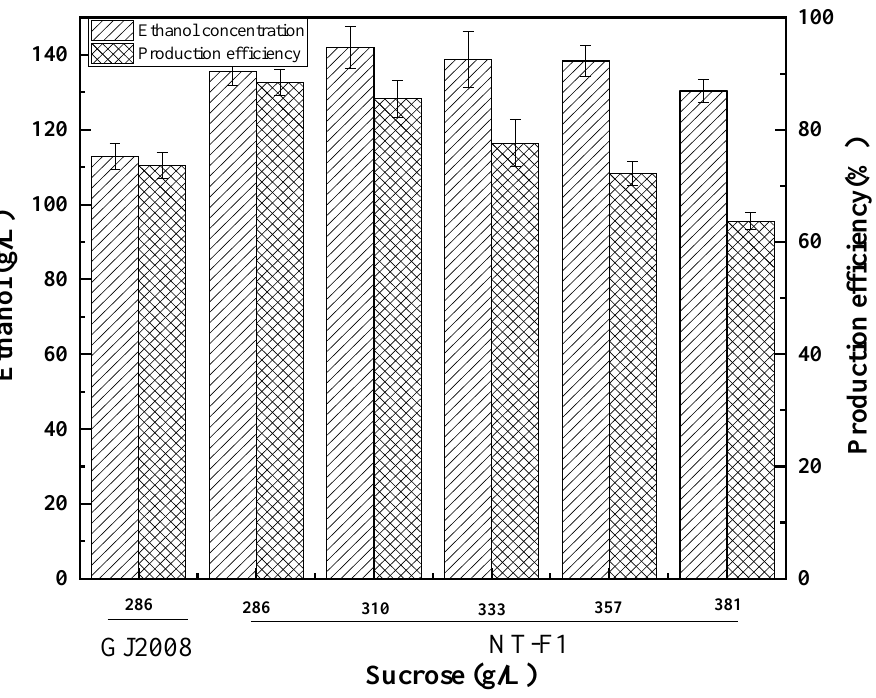
Figure 6. Optimization of sucrose ethanol synthesis by mutant strain. Sucrose fermentation media of 286, 310, 333, 357, and 381 g/L were used to determine the conditions for optimal ethanol production.